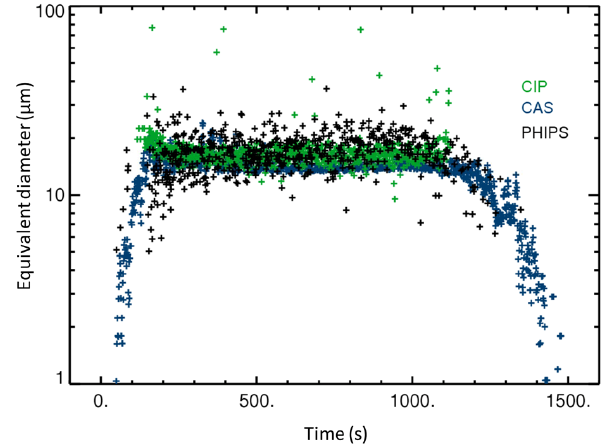
Fig. 15. The time evolution of the median volume diameter obtained from CAPS measurements (CAS (green) and CIP (blue)) and area equivalent diameter from PHIPS measurements (black), for experiment ACI03_23.